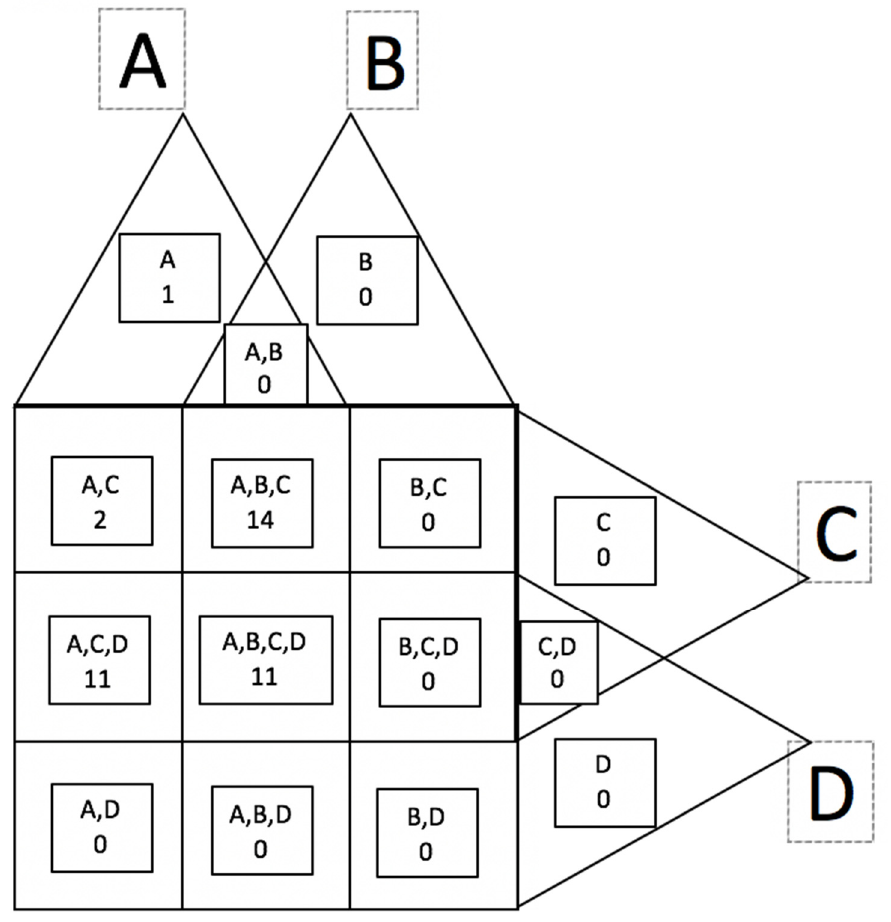
Figure A1. Four variable Venn Diagram of WMP sites’ historic associations. 92% of WMP sites are co-associated with a combination of three or all four of the tested historical features dating to the period of Western Expansion. To merit the desig- nation of “associated”, the WMP site must overlook, be adjacent to, or be located proximal to the named historic feature. The Venn Diagram above illustrates that of the 15 possible combinations of four variables, the 39 WMP sites are concentrated in five combinations, only.